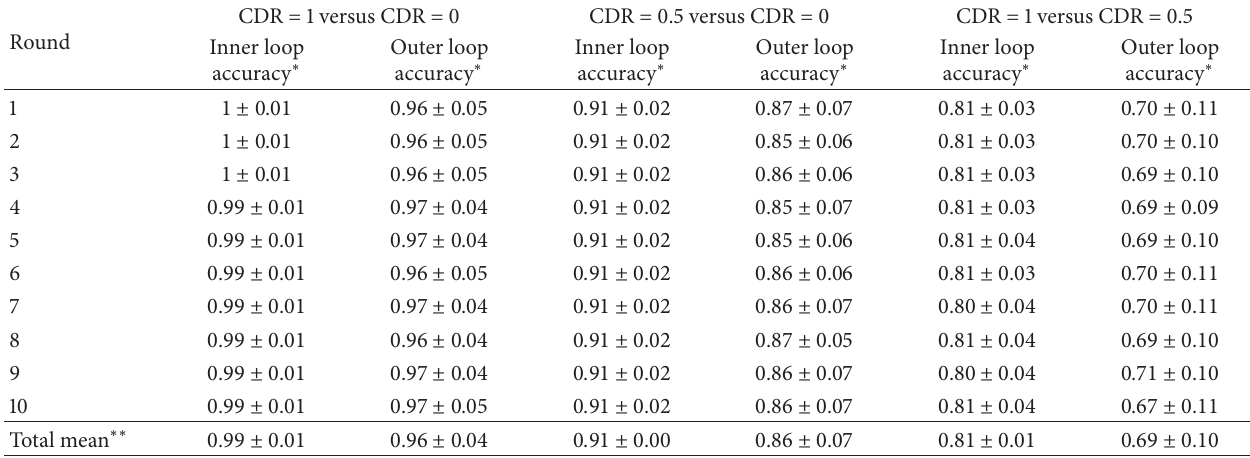
∗ mean ± std averaged across 100 iterations; ∗∗ mean ± std averaged across 100 iterations and 10 rounds.